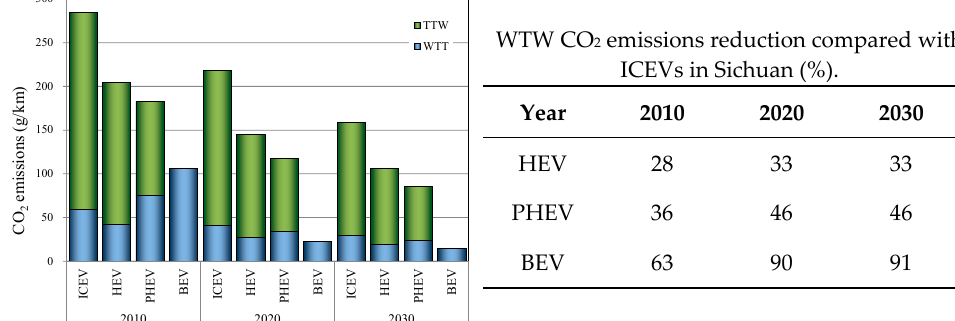
Figure 12. WTW CO 2 emissions of ICEVs/HEVs/PHEVs/BEVs in Sichuan.